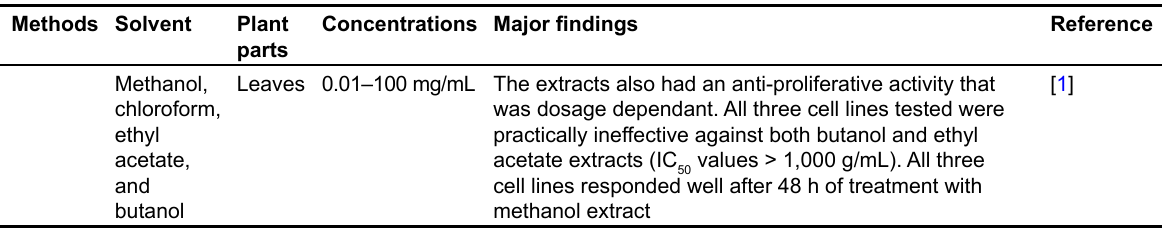
: Resting state; G : Gap 0 7